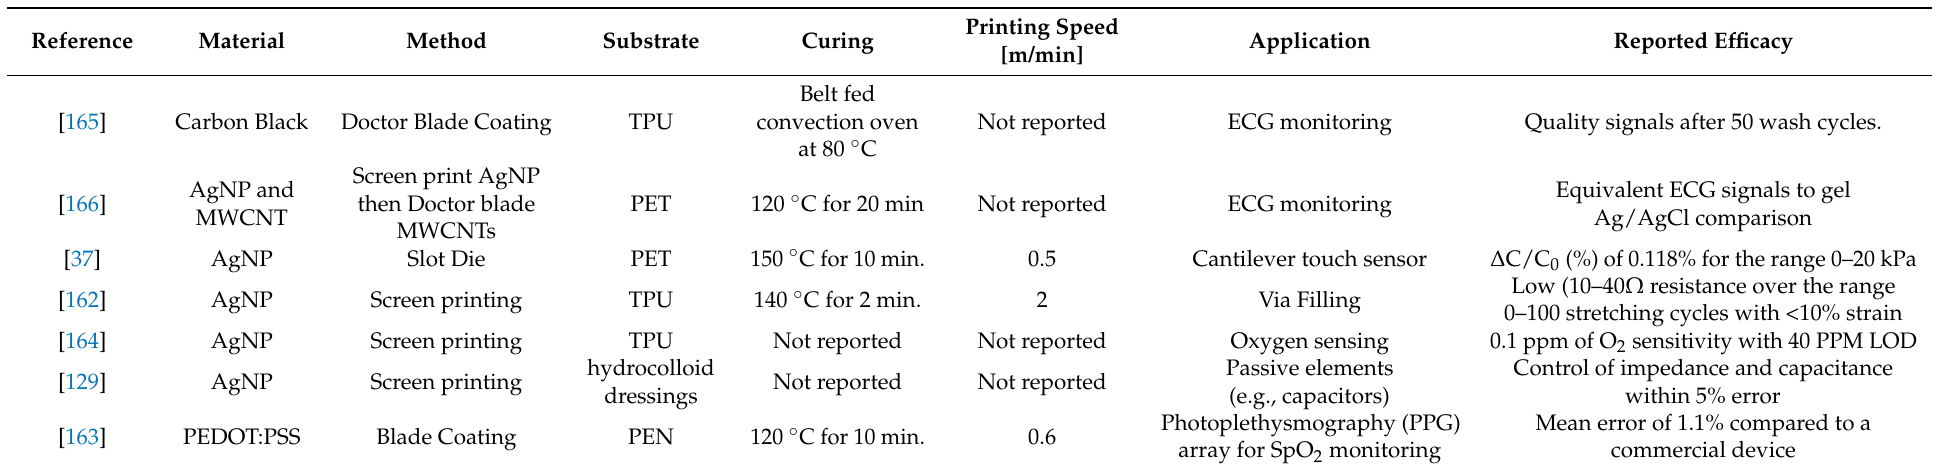
Table 4. Additional bioelectronics applications fabricated with high throughput